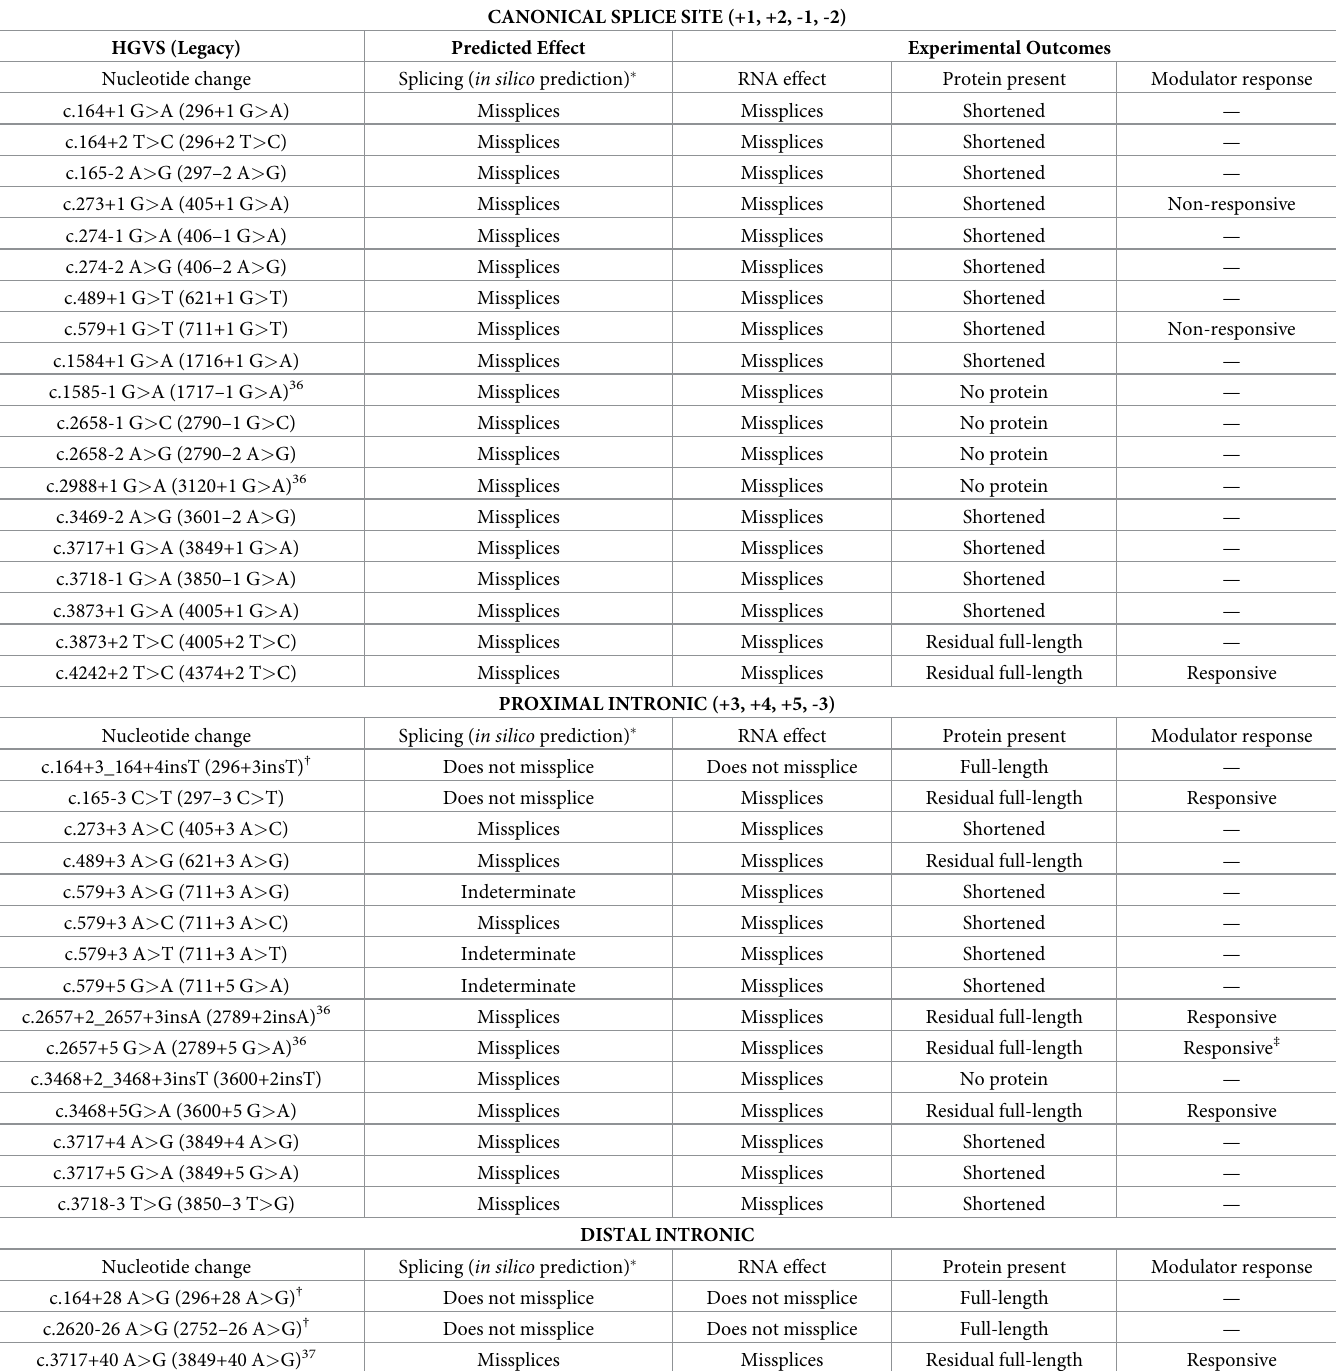
Table 2. Intronic variants evaluated for impact on CFTR mRNA